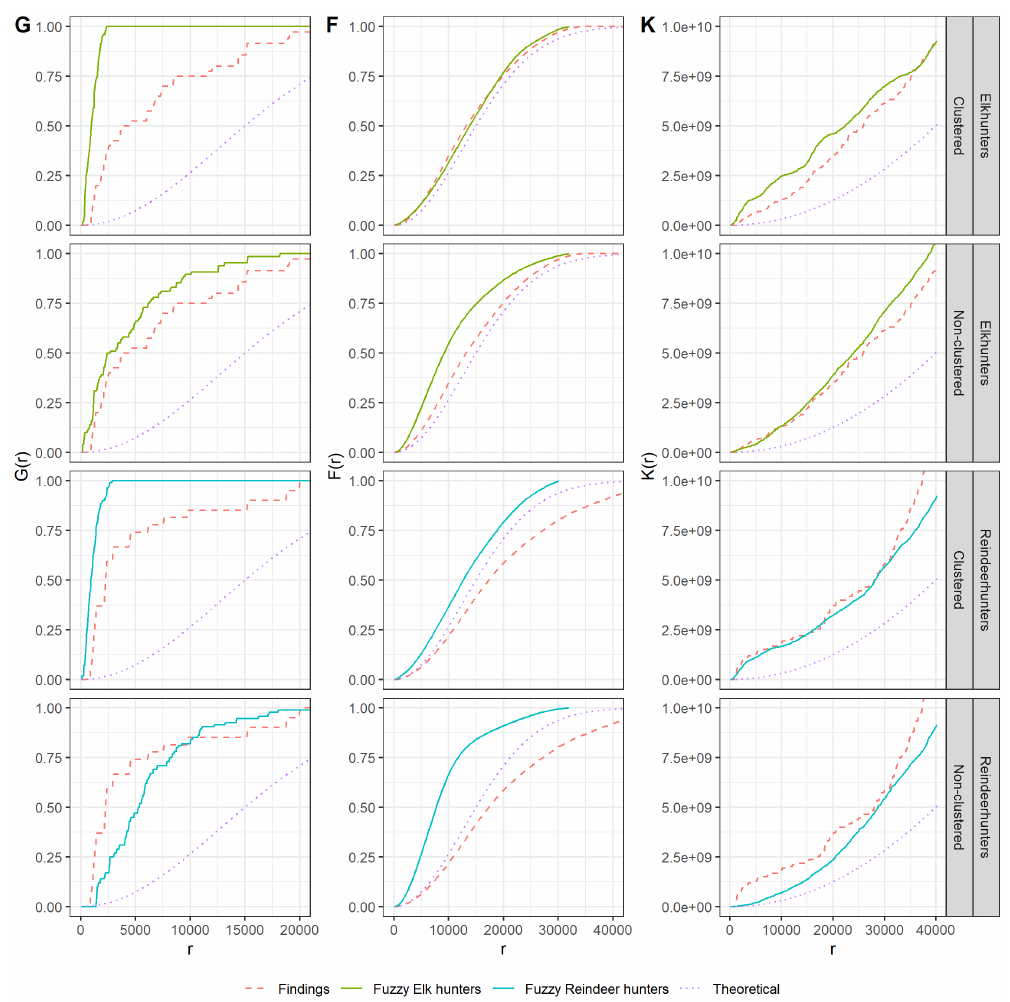
Figure 5. Ripley’s K-, G-, and F-function for clustered and random fuzzy distributions relative to elk hunter and reindeer hunter